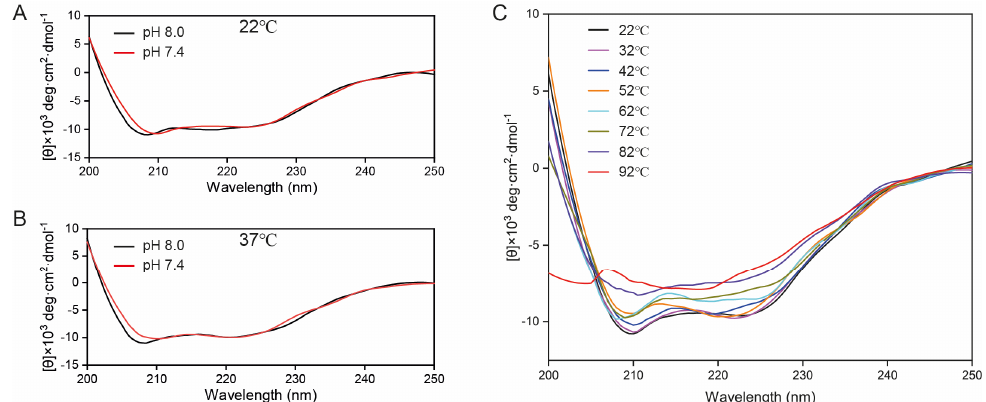
Figure 4. Circular dichroism (CD) spectra of GEP1 151-905 in different pH and temperatures. ( A ) Over- lay of CD spectra in pH 7.4 and 8.0 at 22 °C. ( B ) Overlay of CD spectra in pH 7.4 and 8.0 at 37 °C. ( C ) Temperature-dependent CD spectra in buffer 5 mM HEPES (pH 7.4) and 150 mM NaCl; the temperature range is from 22 °C to 92 °C and is varied in steps of 10 °C.